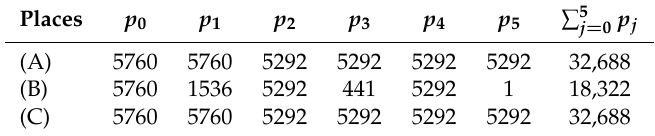
Table 7. Capacities of MP3 playback application under a single-server semantics.